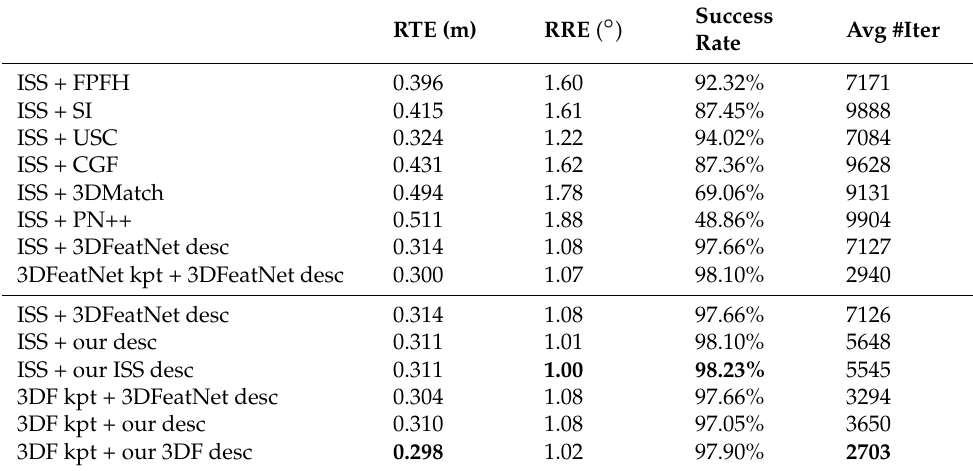
Table 1. Registration error on the Oxford dataset.